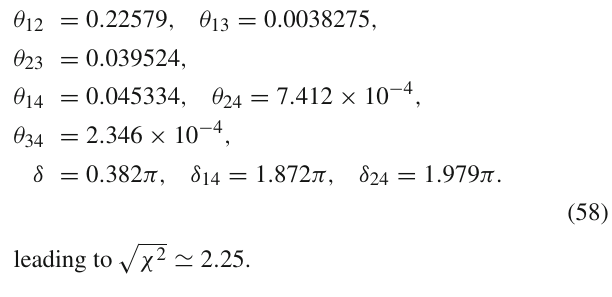
Fig. 7 Results for the allowed parameter regions of our model verifying the conditions in Eqs. (55, 56) and